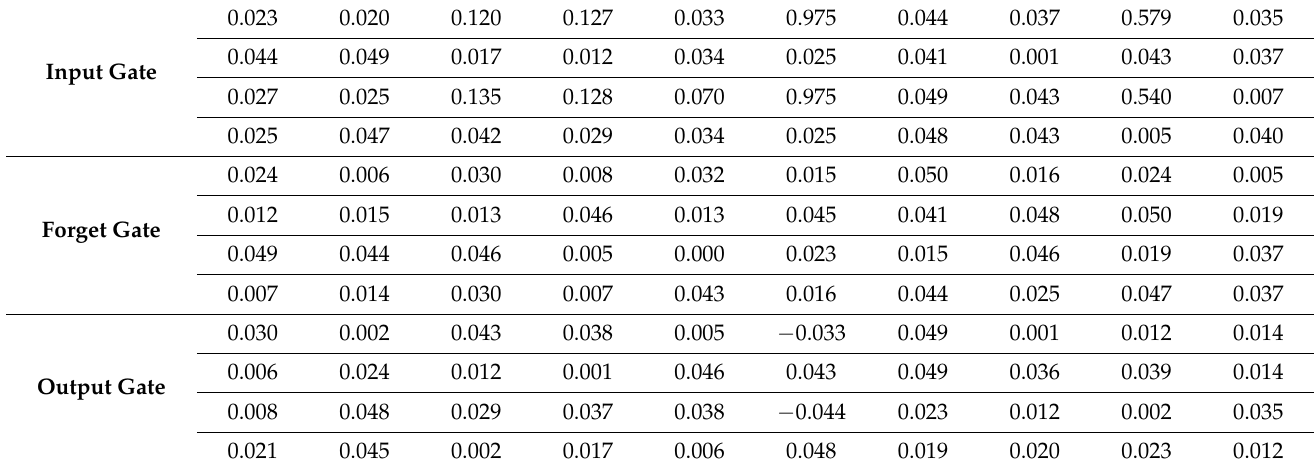
Table 1. The parameters of the equivalent model.